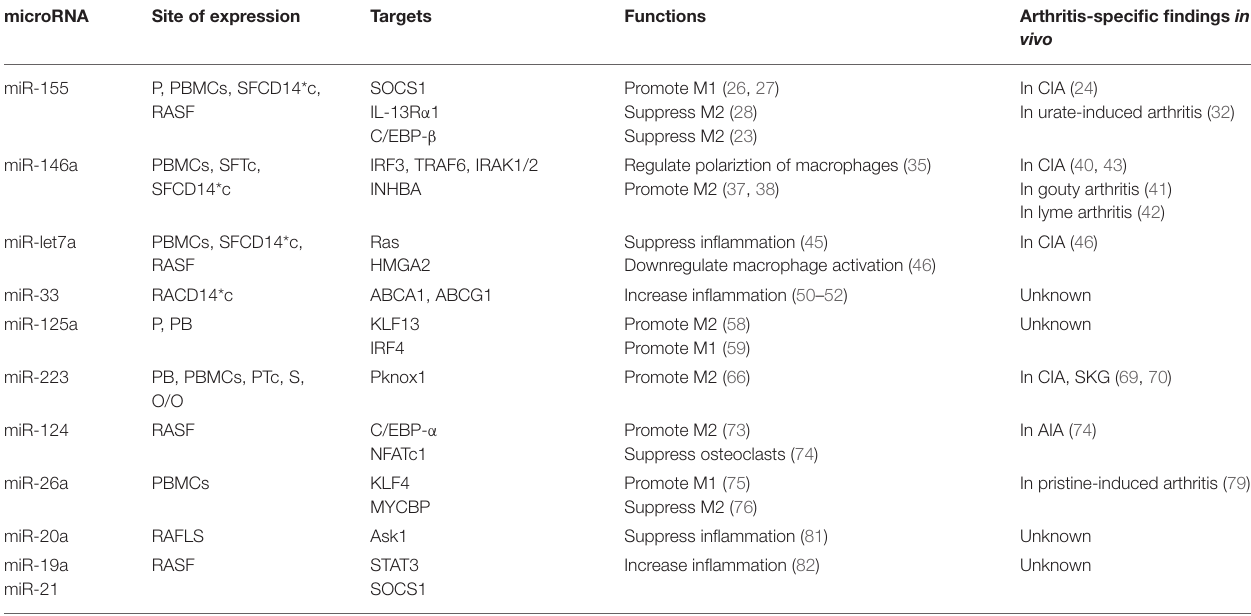
TABLE 1 | MicroRNAs in macrophages and in